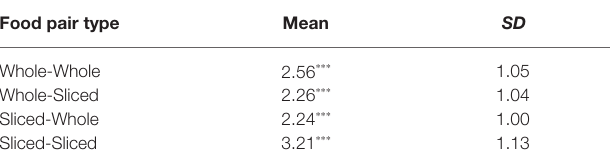
TABLE 1 | Similarity rating for each food pair